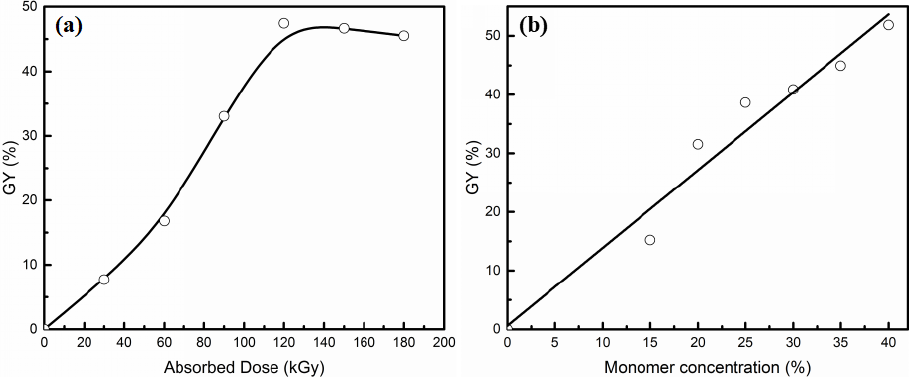
Figure 2. Effect of absorbed dose ( a ) and monomer concentration ( b ) on GY.